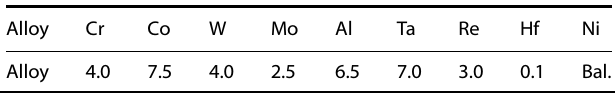
Table 1. Composition (wt.%) of alloy used in the